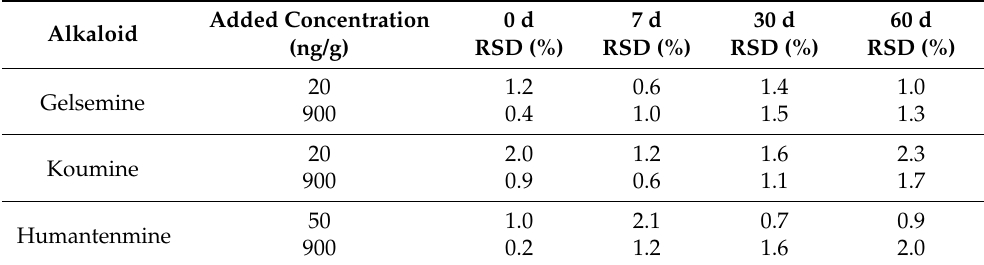
Table 3. Results of standard stock solution stability.